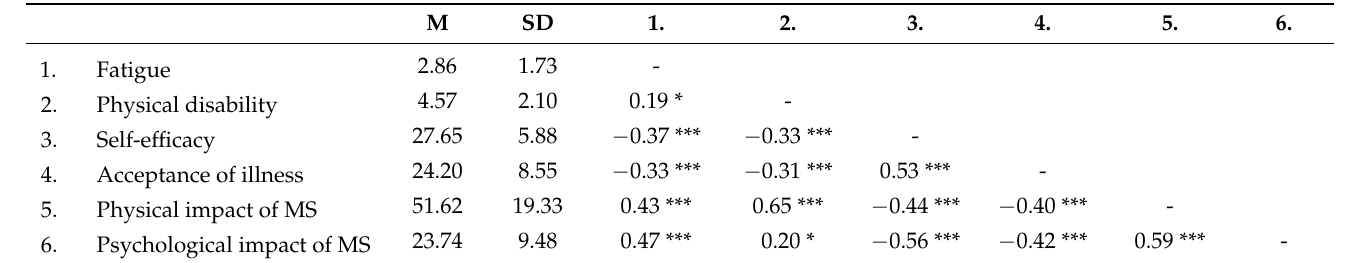
Table 4. Results of the Pearson r correlation.